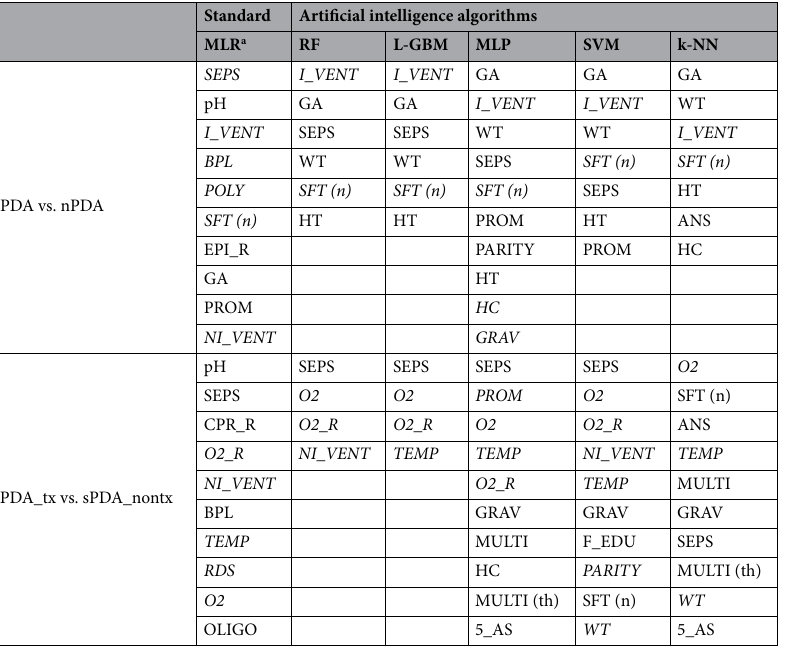
Table 3. Top significant variables for sPDA and sPDA_tx Prediction. sPDA, symptomatic patent ductus arteriosus; nPDA, asymptomatic PDA or spontaneously closed PDA; sPDA_tx, symptomatic patent ductus arteriosus with any treatment; sPDA_nontx, symptomatic patent ductus arteriosus without treatment; RF, random forest; L-GBM, light gradient boosting machine; MLP, multilayer perceptron; SVM, support vector machine; k-NN, k-nearest neighbors. The abbreviations for all factors are shown in Supplementary Table 1. Feature importance describes how relevant a factor is to the model’s predictions. In MLR, the feature importance values were selected according to a p-value of 0.05 during the testing procedure. These are listed in descending order as the absolute values of the coefficients for the MLR and as the average absolute SHAP values for the AAs. The variables in italics indicate positive associations between the selected factors and sPDA or sPDA_tx. a The factor analysis with MLR as the standard reference